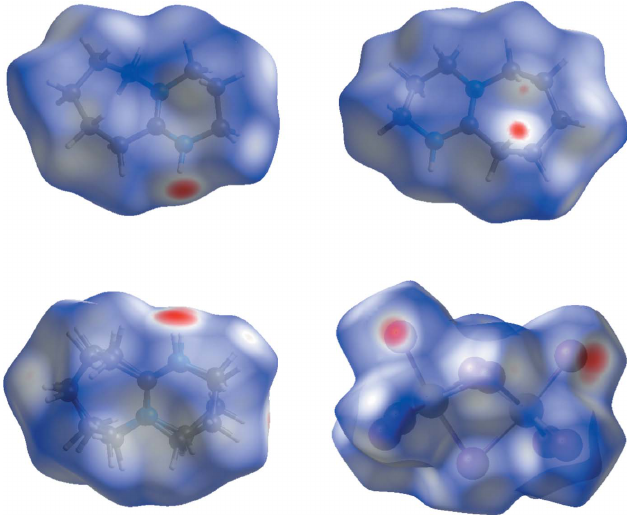
Figure 3 Hirshfeld surfaces, mapped with d norm , of the three crystallographically independent DBUH + cations and the [Bi 2 I 9 ] 3 (cid:2) anion. The red areas correspond to regions where contacts are shorter than the sum of the van der Waals